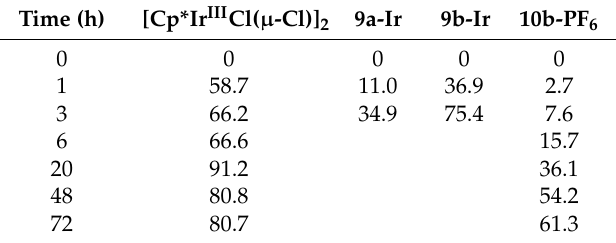
Table 2. Yields (%) of product over time (h) using 9a-Ir , 9b-Ir , 10b-PF 6 , or [Cp*Ir III Cl( μ -Cl)] 2 . [a] Time